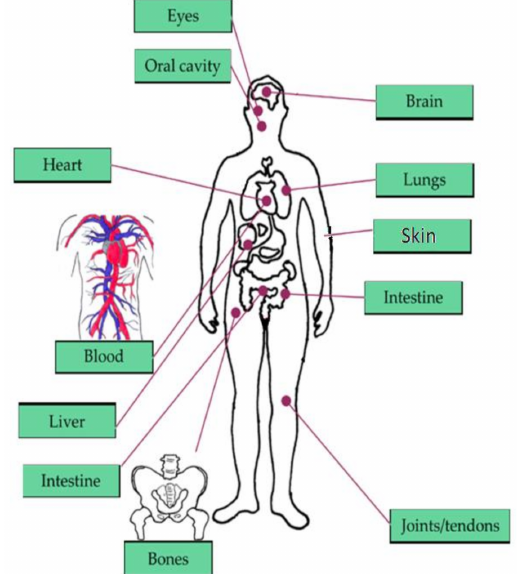
Figure 1. Vital signs and organs of the human body focused in our literature survey